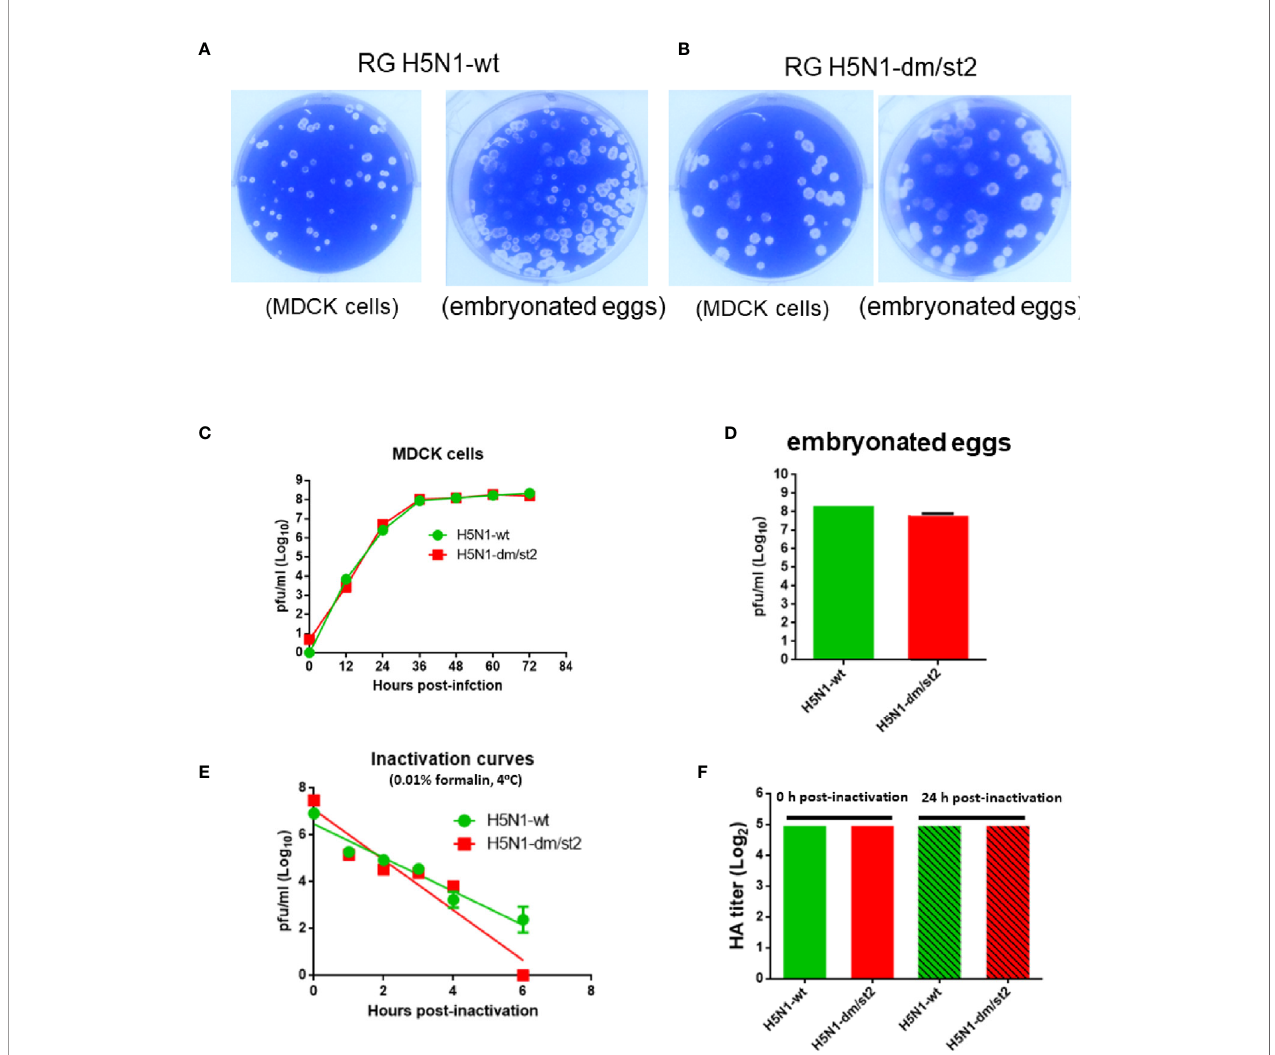
FIGURE 7 | Generation and characterization of H5N1 RG viruses containing the H5-wt or H5-dm/st2 gene. (A) Viral plaques of RG H5N1-wt virus propagated in MDCK cells and embryonated chicken eggs. (B) Viral plaques of RG H5N1-dm/st2 virus propagated in MDCK cells and embryonated chicken eggs. (C) Propagation kinetics of RG H5N1-wt and H5N1-dm/st2 RG viruses in MDCK cells. (D) The peak titers of RG H5N1-wt and H5N1-dm/st2 RG viruses propagated in embryonated chicken eggs. (E) Formalin inactivation kinetics of RG H5N1-wt and H5N1-dm/st2 RG viruses. (F) The HA contents of RG H5N1-wt and RG H5N1-dm/st2 viruses before and after formalin